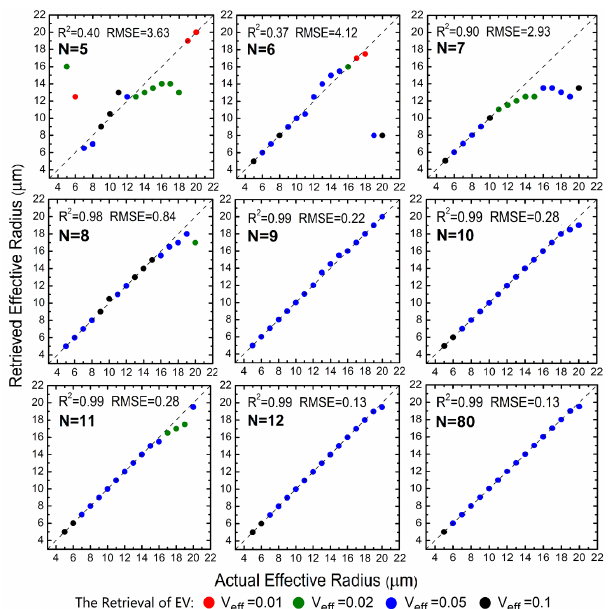
Figure 4. Comparisons of the retrieved CDR and EV with the actual values assumed in the RT3 modeling. In all cases, the actual EV and the COT were assumed to be 0.05 and 5, respectively. N in every plot represents the number of POLDER-like reflectances employed in the inversion. From the top left to the bottom right, N increases from 5 to 12. As N increases from 12 to 100, the R 2 and the RMSE are stable at 0.99 and 0.13, respectively. The case for N = 80 is given last. The color of the points represents the EV results.